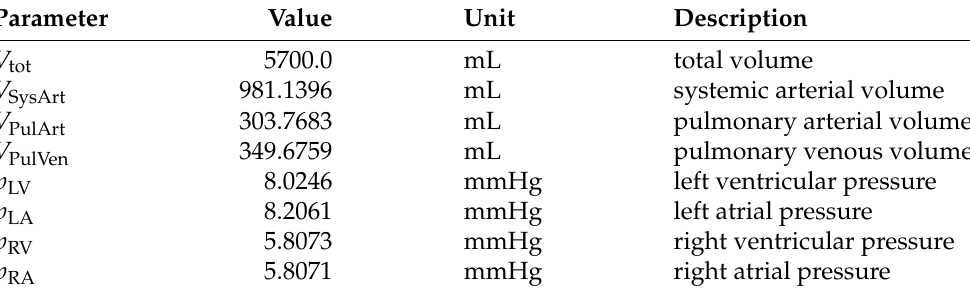
Table 5. Initial conditions for the circulatory system